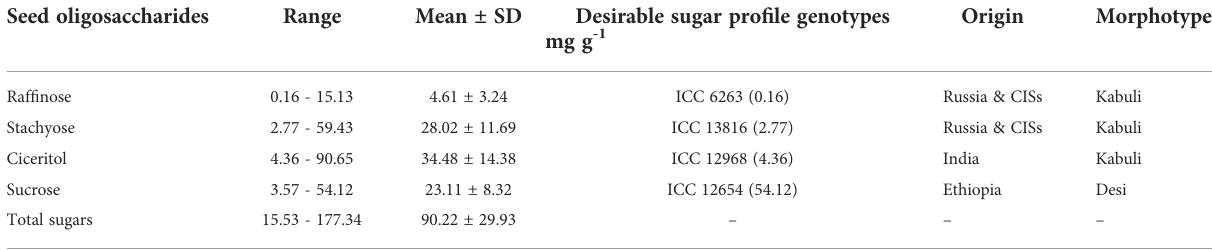
TABLE 1 Variability of chickpea accessions for seed oligosaccharide contents. Seed oligosaccharides